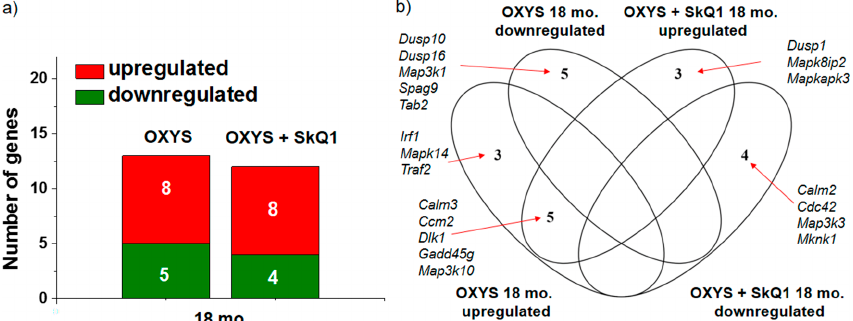
those known to be involved in the p38 MAPKsp ( a ). The Venn diagram depicts overlapping sets of DEGs in control and SkQ1-treated 18-month-old OXYS rats compared of untreated Wistar rats ( b